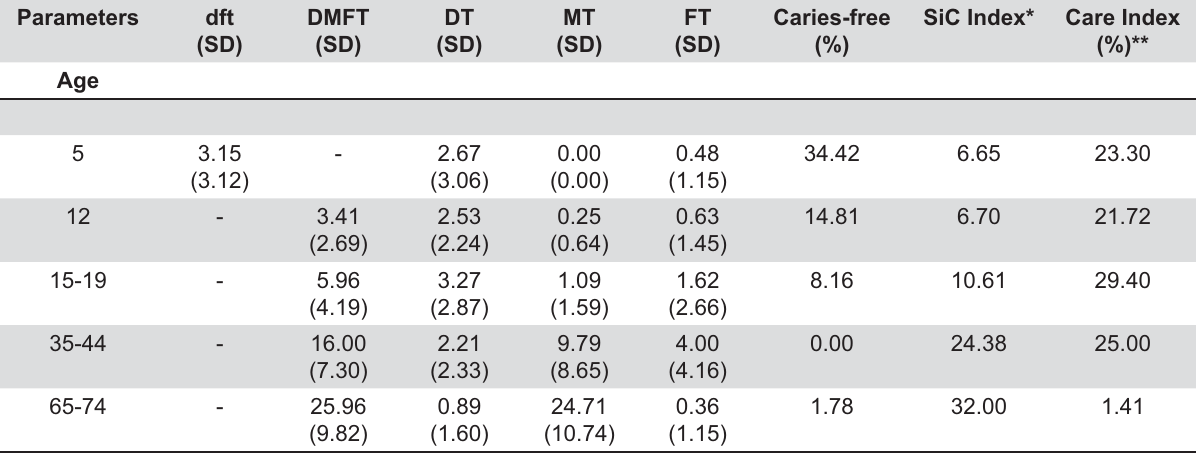
Table 2- (cid:7)(cid:1)(cid:2)(cid:3)(cid:4)(cid:5)(cid:6)(cid:7)(cid:8)(cid:5)(cid:9)(cid:10)(cid:2)(cid:11)(cid:7)(cid:30)(cid:24)(cid:22)(cid:4)(cid:31)!(cid:1)"(cid:7)(cid:5)(cid:3)(cid:24)(cid:7)(cid:1)(cid:15)#$(cid:31)!(cid:1)"%(cid:7)(cid:24)(cid:10)(cid:11)(cid:4)(cid:9)(cid:10)&’(cid:4)(cid:10)(cid:13)(cid:3)(cid:7)&*(cid:7)(cid:8)(cid:13)(cid:20)(cid:12)(cid:13)(cid:3)(cid:2)(cid:3)(cid:4)(cid:7)(cid:30)(cid:24)(cid:2)(cid:8)(cid:5)*(cid:2)(cid:24)(cid:7);(cid:7)(cid:1)$(cid:31)!(cid:1)"(cid:18)(cid:7)(cid:20)(cid:10)(cid:11)(cid:11)(cid:10)(cid:3)(cid:17)(cid:7);(cid:7)(cid:15)$(cid:31)!(cid:1)"(cid:18)(cid:7)(cid:14)(cid:6)(cid:6)(cid:2)(cid:24)(cid:7);(cid:7) FT(SD)], Caries-free (%), SiC Index and Care Index in each age studied